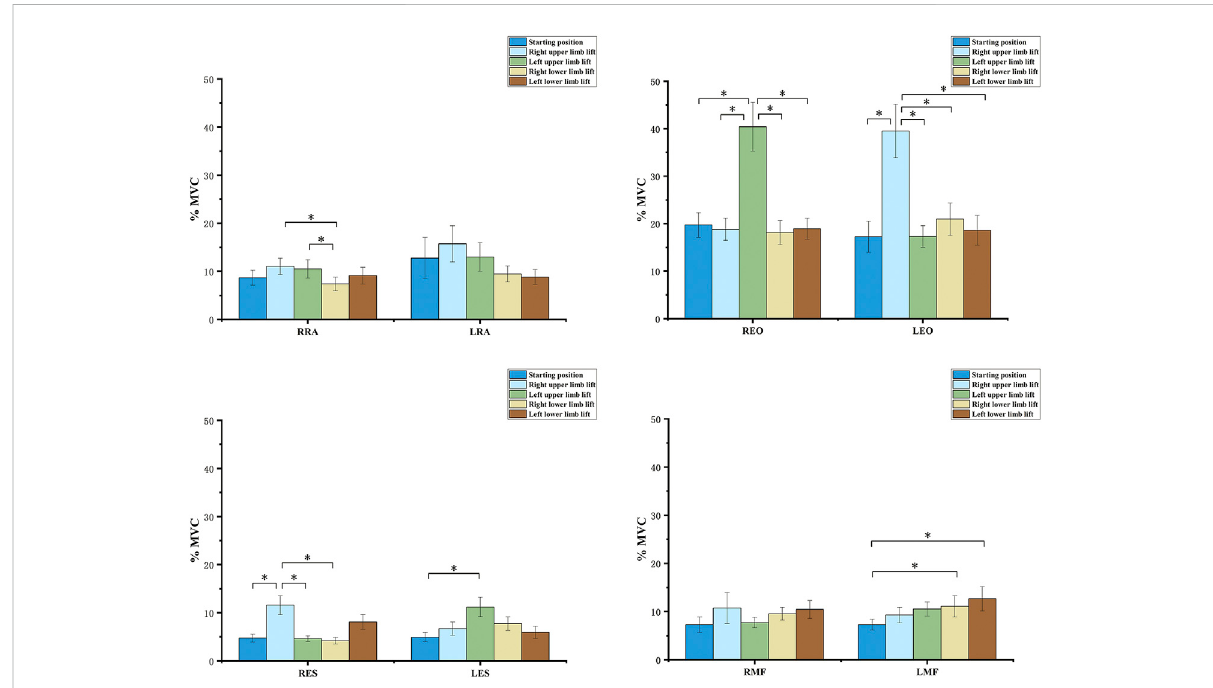
FIGURE 5 sEMG values and results of one-way ANOVA during the four-point hand − foot kneeling positions, respectively. The negative value meant the vertebra rotates to the left, and the positive value meant the vertebra rotates to the right. RRA, right rectus abdominis; LRA, left rectus abdominis; REO, right external oblique; LEO, left external oblique; RES, right erector spinae; LES, left erector spinae; RMF, right lumbar multi fi dus; LMF, left lumbar multi fi dus. *: statistically signi fi cant, p < 0.05.